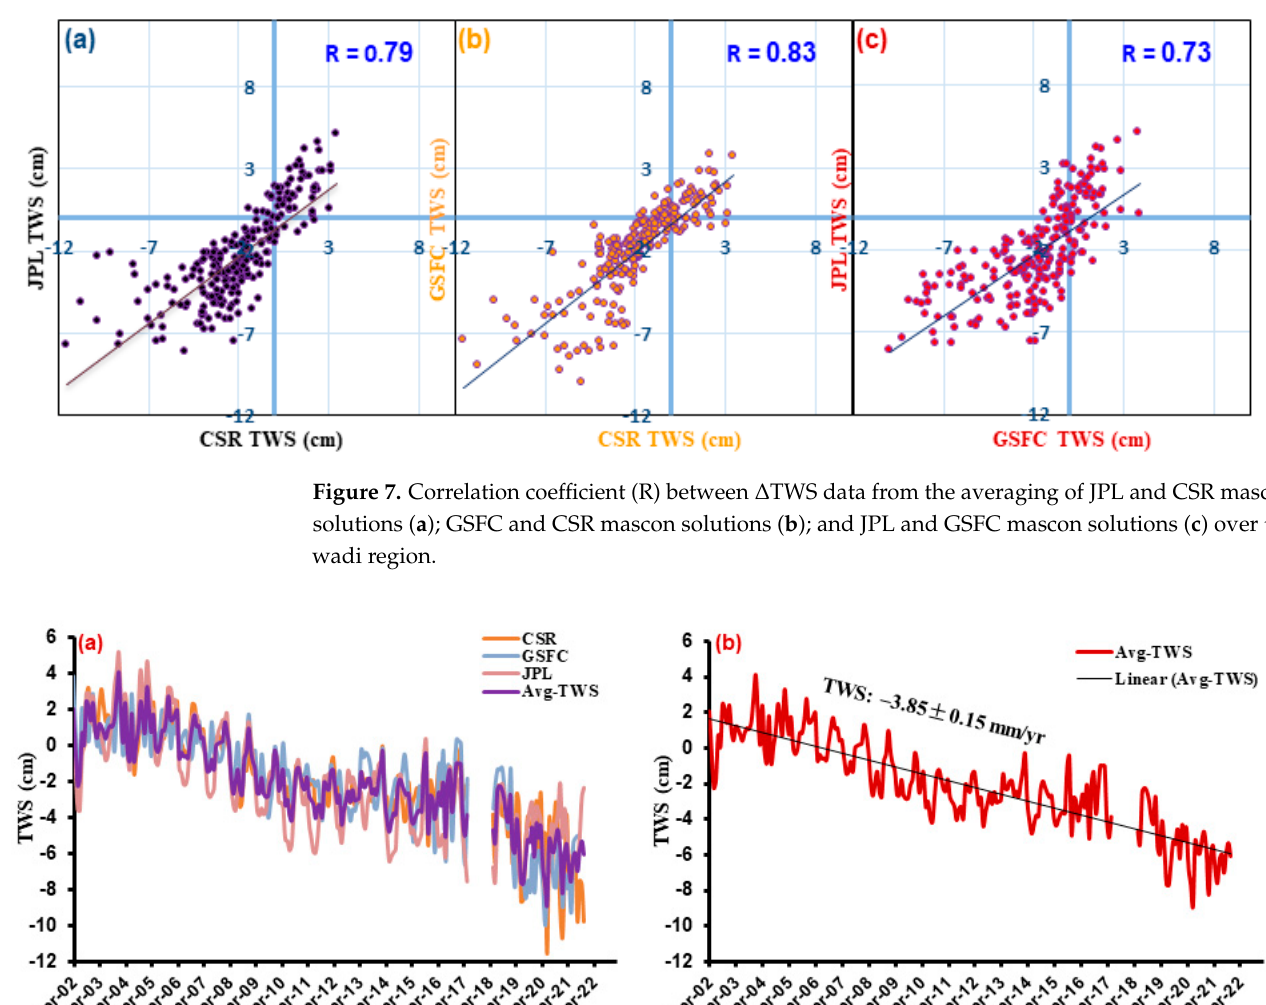
Figure 6. ( a ). Spatiotemporal variations in GRACE-derived ∆ TWS trend for the study area derived from mascon CSR solutions. ( b ). Spatial variations in the average GRACE-derived TWS values for the study area derived from mascon CSR solutions between 2002 and 2021.